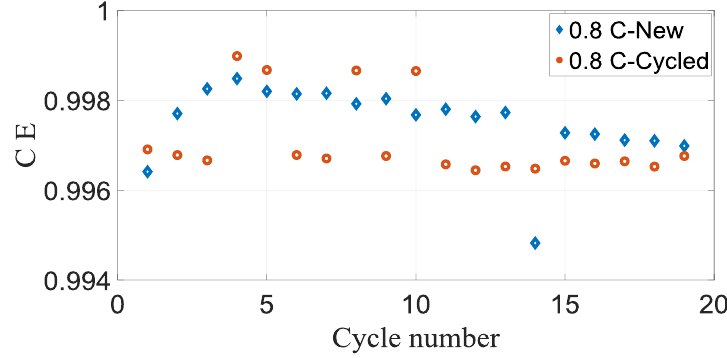
Figure 7. A comparison between coulombic efficiencies for 0.4 C.